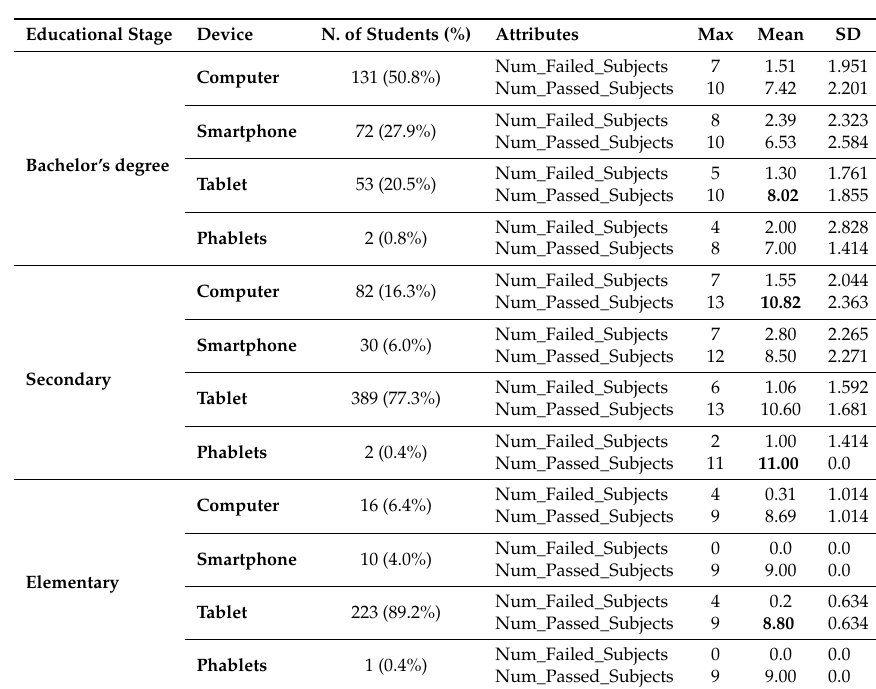
Table 5. Number of students, percentage, maximum, mean and standard deviation of number of passed and failed subject for students who have ever logged in the LMS according to the educational stage and connecting device. The best results considering the mean number of subjects passed for each educational stage are highlighted in